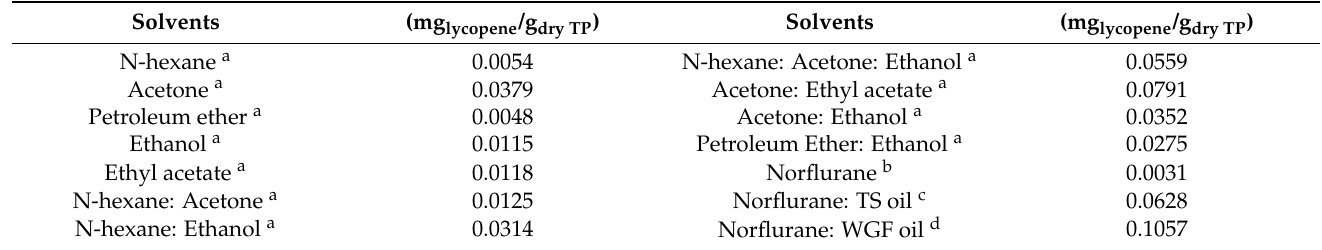
Table 4. Lycopene content in tomato peels extracts obtained by common organic solvents and Norflurane with tomato seeds (TS) and wheat germ flour (WGF)